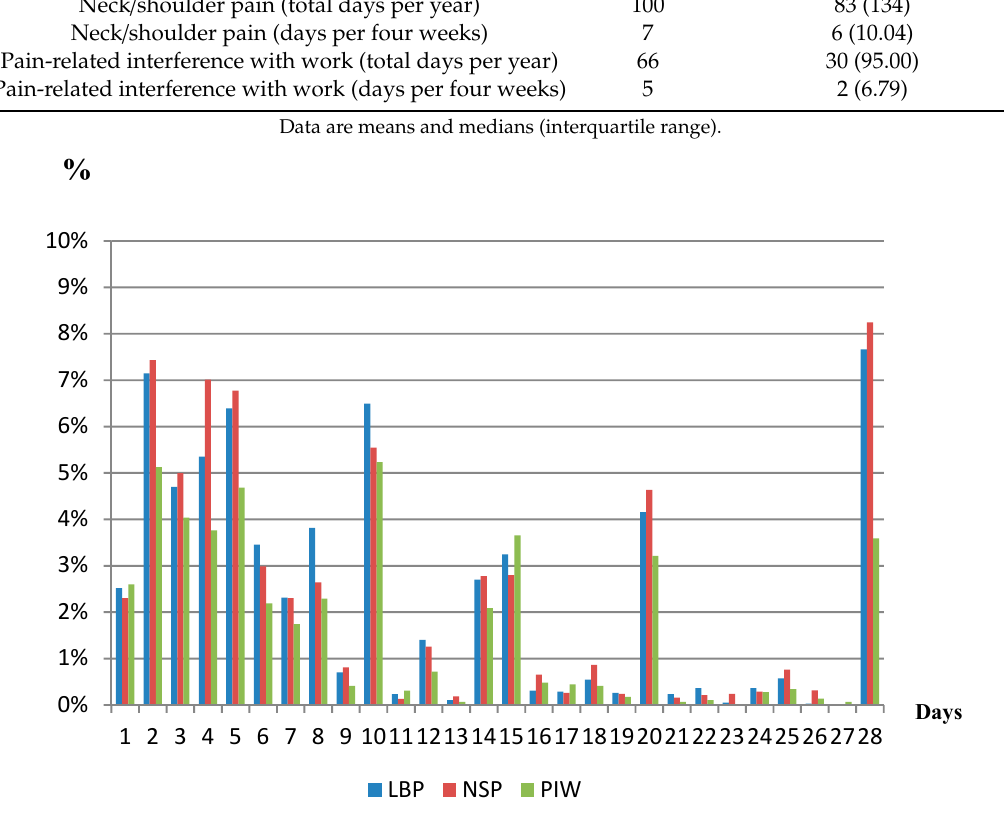
Figure 1. Distribution in percentage of the study population of the length of pain episodes lasting from 1 to 28 days. LBP: low back pain; NSP: neck/shoulder pain; PWI: pain-related interference with work.